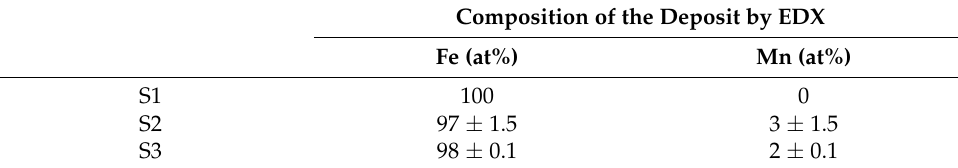
Table 2. Atomic percent of Fe and Mn in the three deposits obtained with EDX.